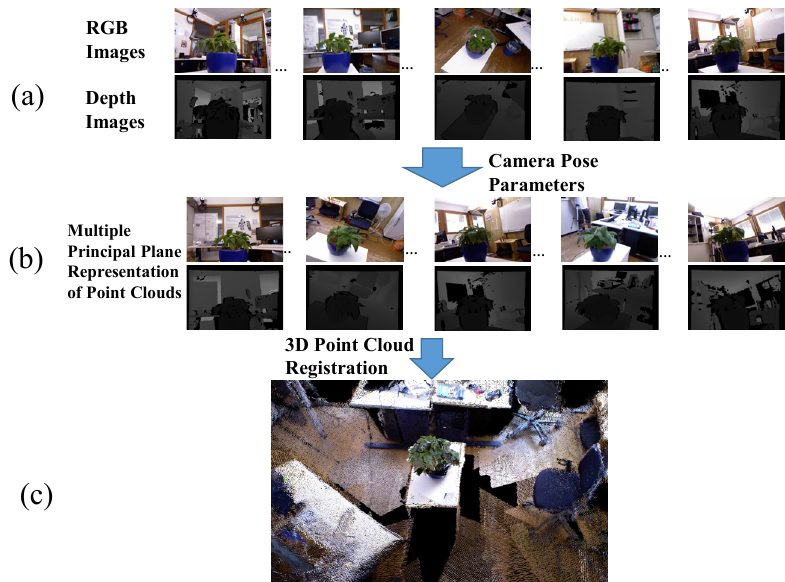
Figure 2. Example of 3D Scene Reconstruction using the dataset ‘freiburg1-plant’ [44]: ( a ) Multiview RGB-D video; ( b ) the unprojecting result of each frame in ( a ) using the proposed multiple principal plane analysis on the corresponding point cloud; ( c ) the unprojected image of the whole scene point cloud which is generated by the 3D point cloud registration algorithm [34].